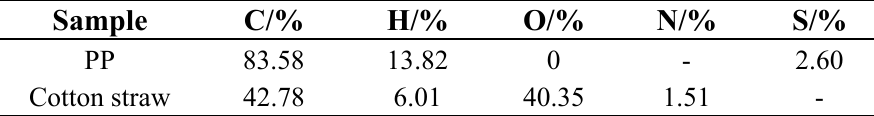
Table 4. Elemental analysis of cotton straw and PP.